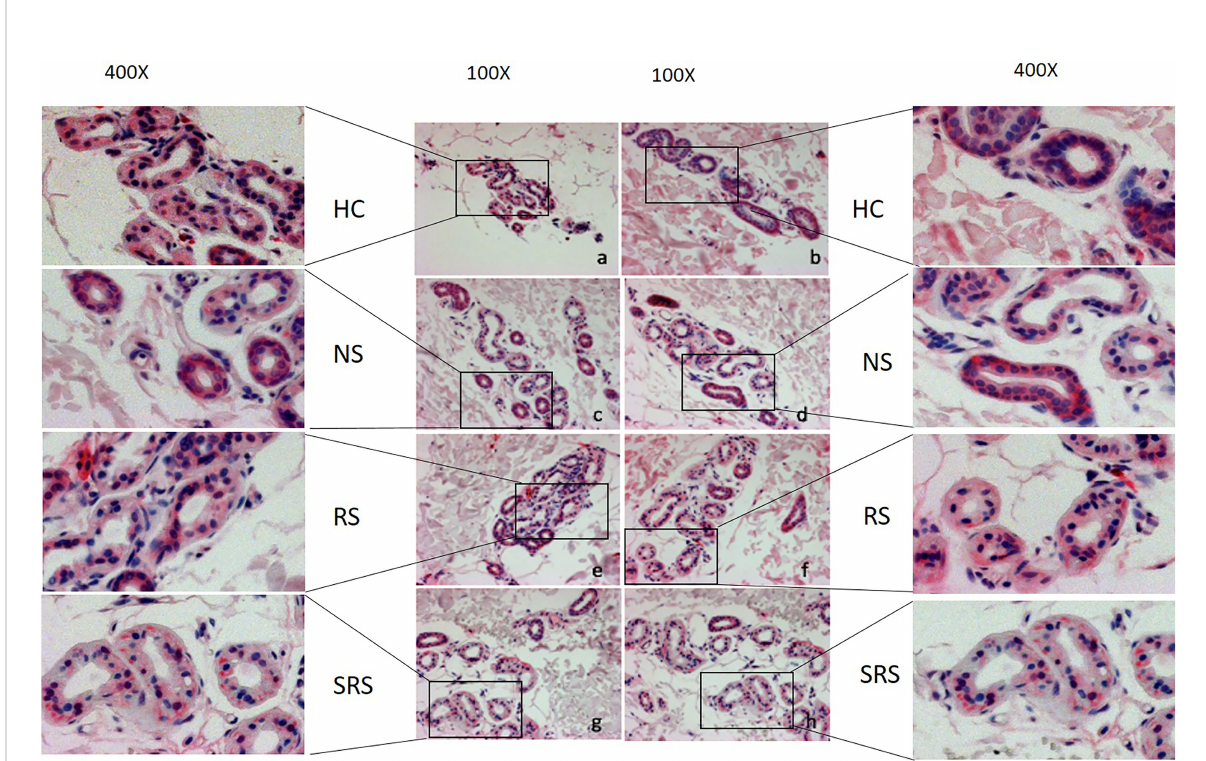
FIGURE 2 Representative immunohistochemical examination patterns of the expression of CHRM3 of HC and CholU patients separated per sweating group: (a/ c/ e/ g) non-lesional skin samples taken before provocation, (b) non-lesional skin after provocation from a sample of the HC group, and (d/ f/ h) lesional skin samples after provocation from CholU patients. Zoom-in boxes depict the cutouts in higher magni fi cations. HC, healthy controls; NS, normal sweating CholU; RS, reduced sweating CholU; SRS, severely reduced sweating